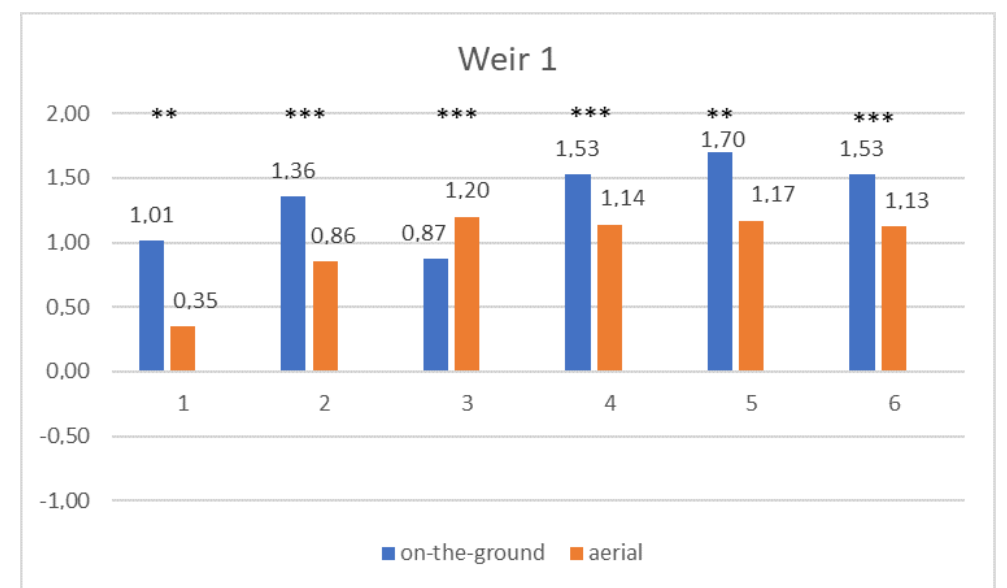
Figure 10. Mean values for preference ratings for pairs of scenarios developed from on-the-ground and aerial perspectives for weir 1 at Bogstadhølen. Differences between mean values are indicated at the respective significance levels: ***, p ≤ 0.001; **, p ≤ 0.01; and *, p ≤ 0.05.